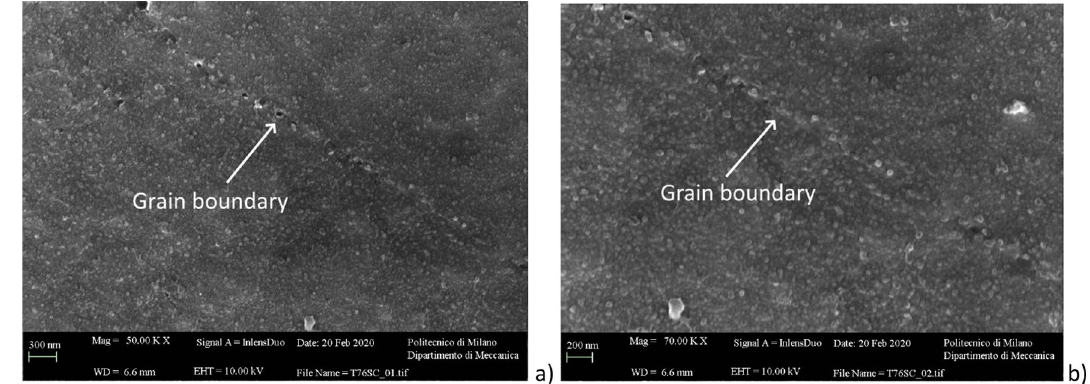
Fig. 15 Precipitate distribution at the grain boundaries—T76SC temper. b is the magnification of